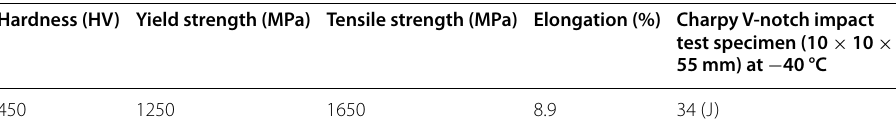
Table 8 The mechanical properties of the Armox 500T steel plate